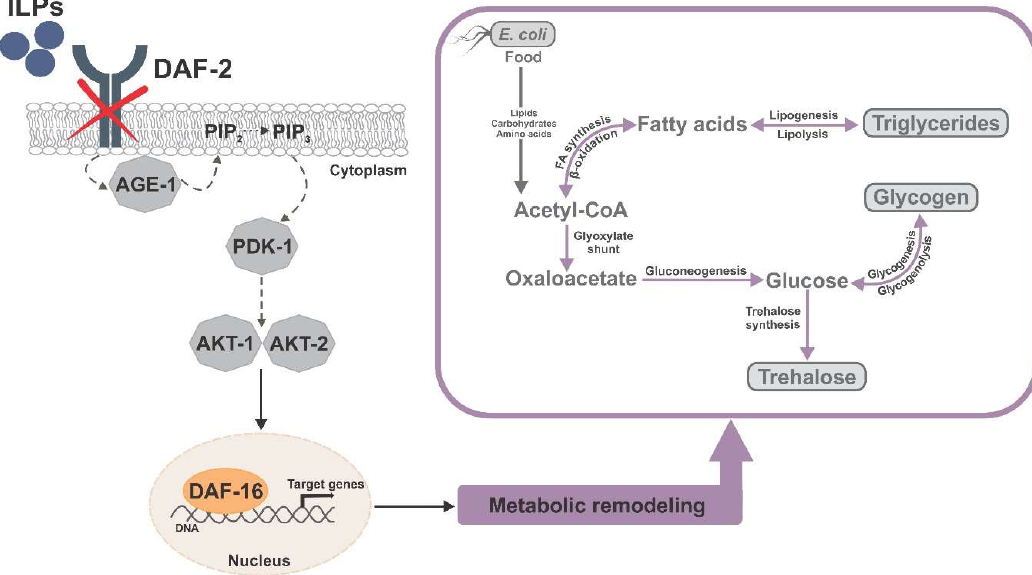
Figure 1. Simplified graphic summary of the DAF-16-dependent metabolic remodeling in the Caenorhabditis elegans daf-2 mutant, with emphasis on the major carbon stores and their